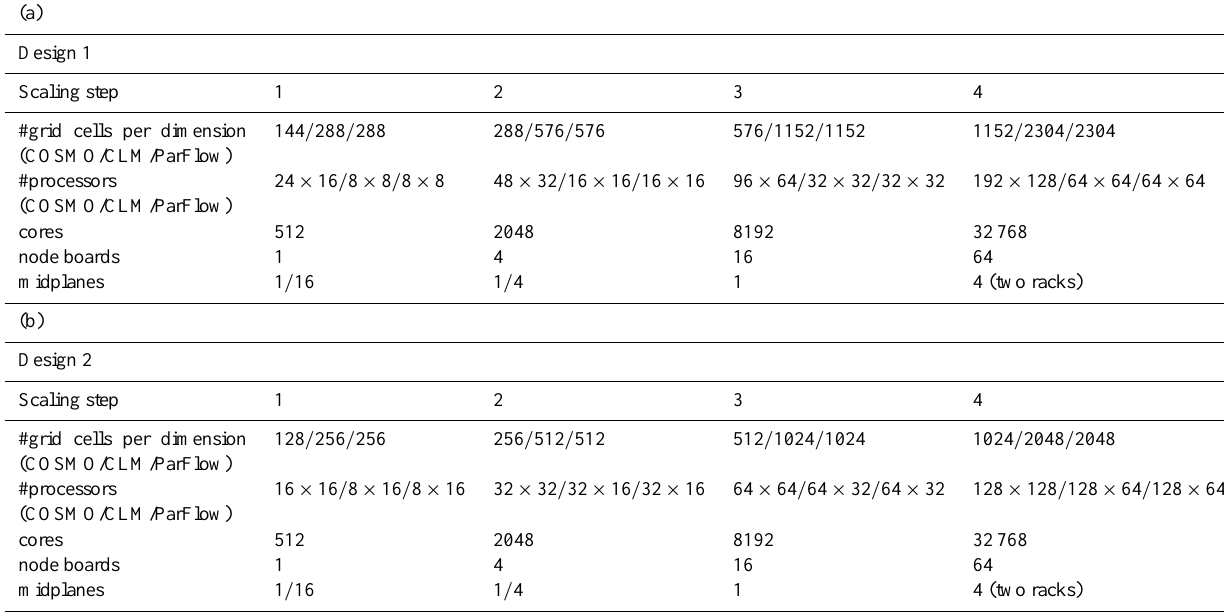
Table 1. Summary of experimental design setup for scaling